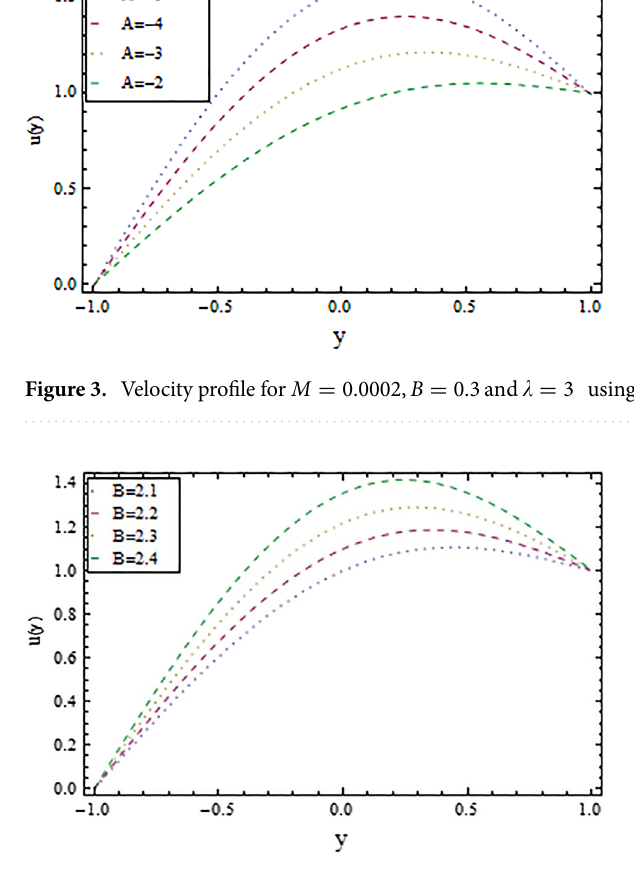
Figure 4. Velocity profile for A = − 1, M = 0.0015 and (cid:31) = 2 using OHAM.